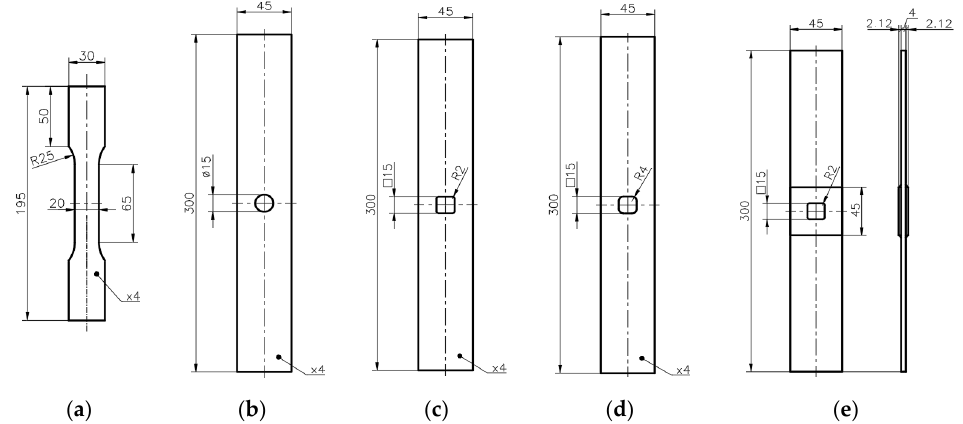
Figure 1. Stress–strain curves for samples made of TVR 380 with stacking sequence: ( a ) θ = [0°]8; ( b ) θ = [+45°/ − 45°]4; ( c ) θ = [90°].